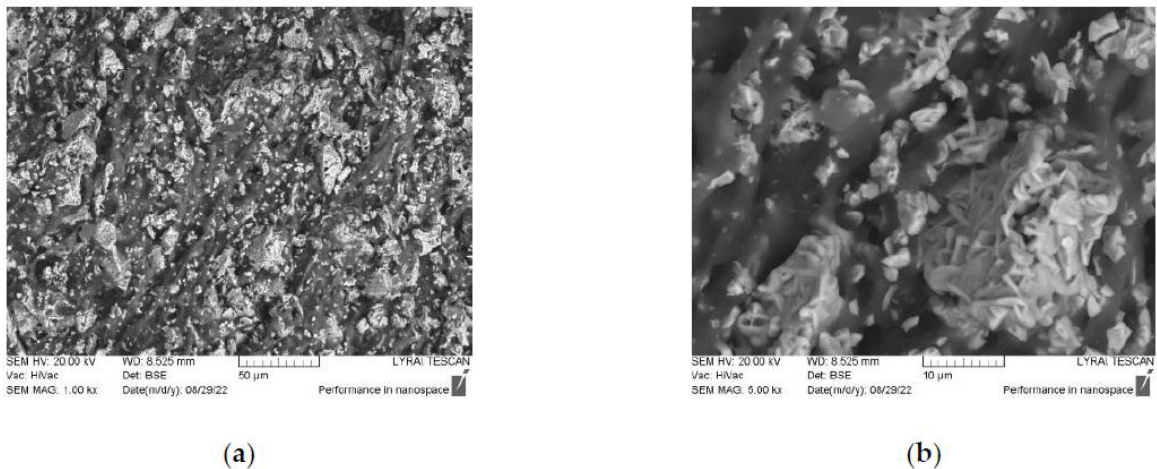
Figure 2. SEM images of ( a ) sample P4B and ( b ) zoomed area of a cluster. Figure 3 presents the hysteresis curves of the Ba 0.5 Sr 1.5 Zn 0.5 Ni 1.5 Fe 12 O 22 , Ba 0.5 Sr 1.5 ZnNiFe 12 O 22 , Ba 0.5 Sr 1.5 Zn 1.2 Ni 0.8 Fe 12 O 22 and Ba 0.5 Sr 1.5 Zn 2 Fe 12 O 22 powders. The curves